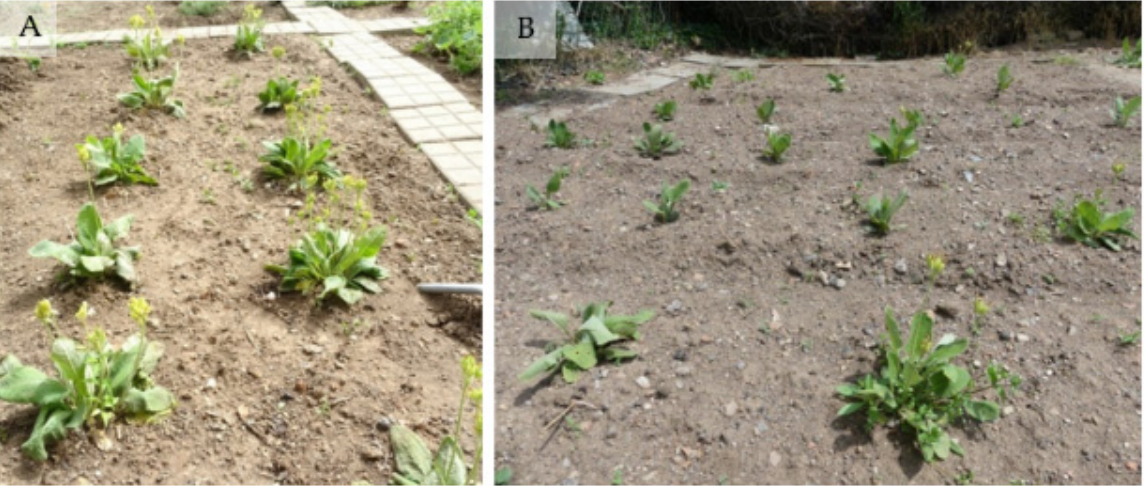
Figure 6. Ex situ collection of P. veris : ( A ) Plants brought from the natural populations; ( B ) Plants grown from seeds and transferred to the experimental field plot.